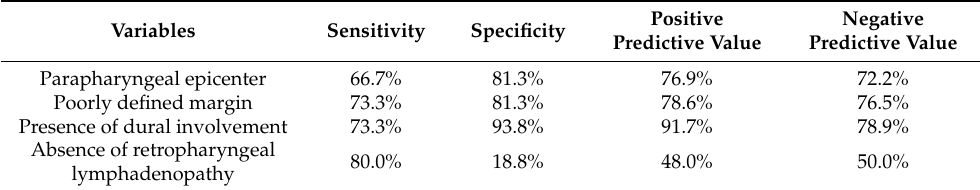
Table 5. Diagnostic performance of variables for differentiating GPA from NPC.